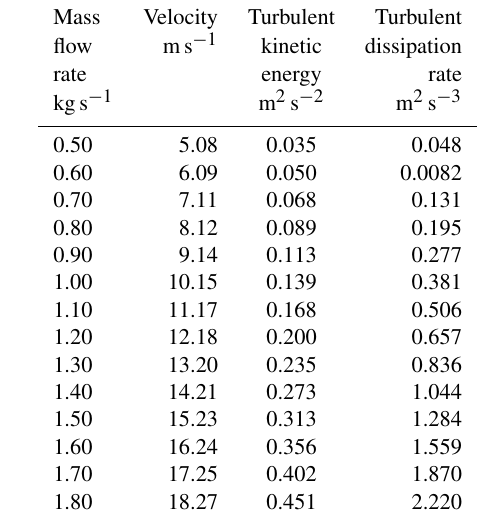
Table 1. Inlet boundary conditions for simulations relative to both cones. Mass Velocity Turbulent Turbulent flow ms − 1 kinetic